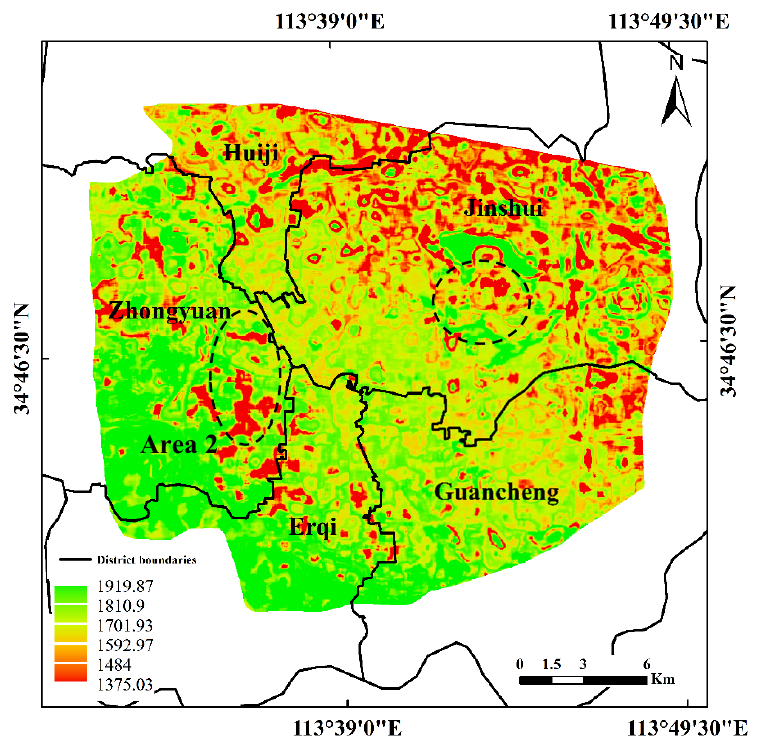
Figure 7. The landscape visual effect of Zhengzhou city, 2017.